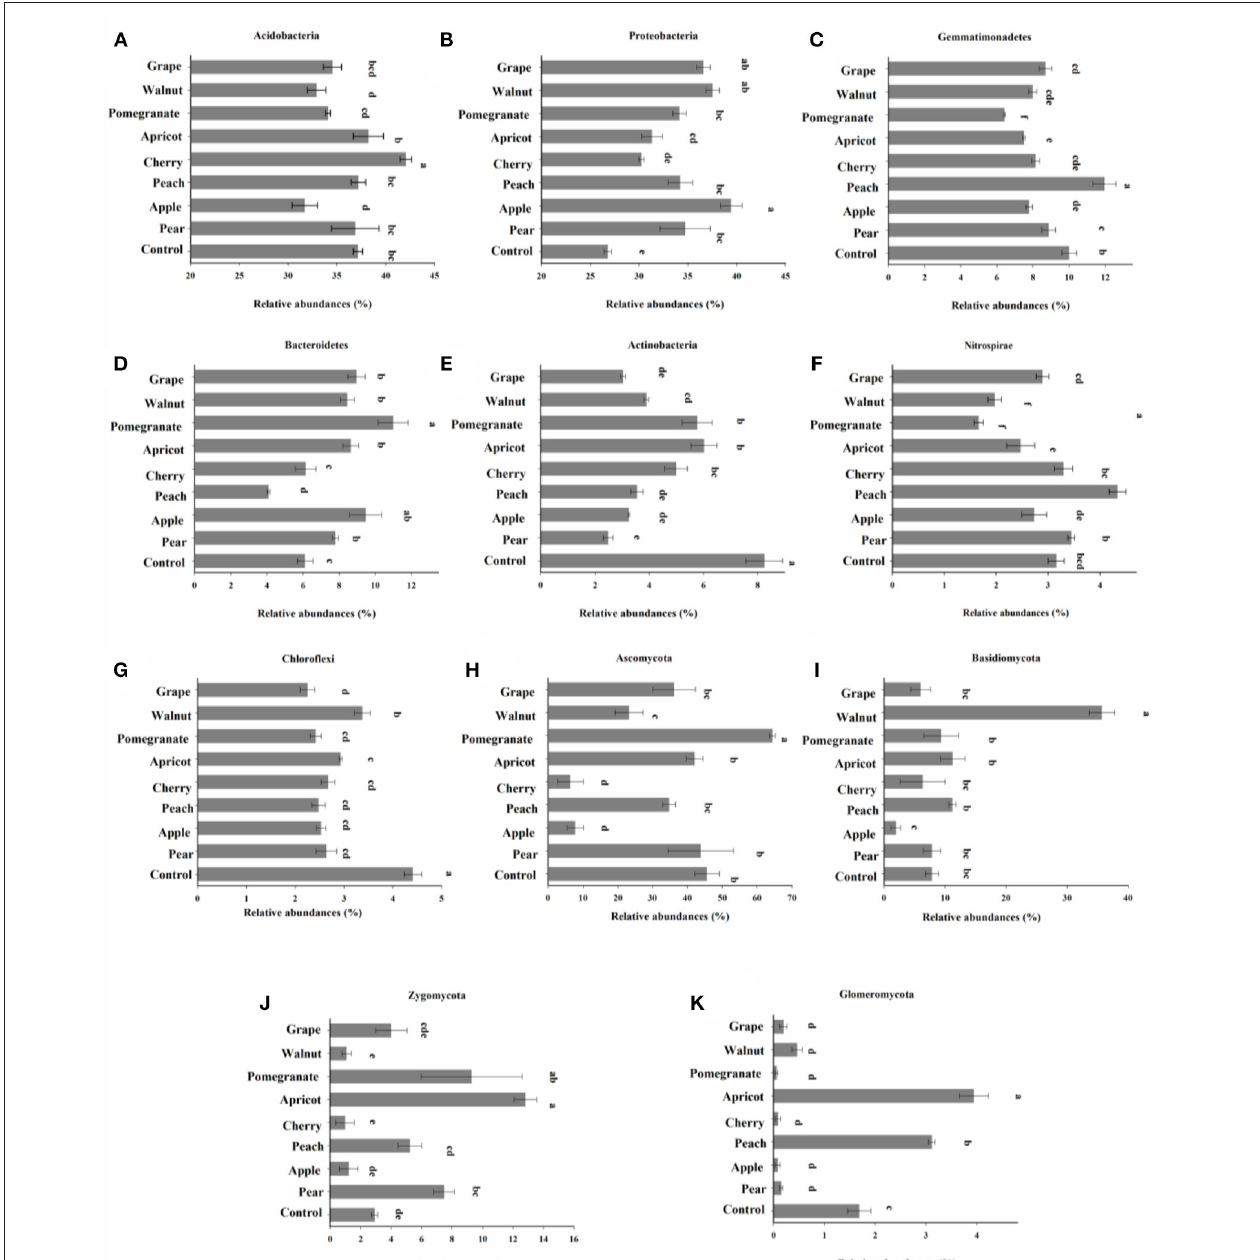
FIGURE 5 | Relative abundances (%) of bacterial phyla ( A–G ; > 1.0% of total composition in all samples) and fungal phyla ( H–K ; > 0.01% of total composition in all sample). Values are means ± SE. Suffixes in the same row indicate statistical significance at p < 0.05 using one-way analysis of variance with tree species as the